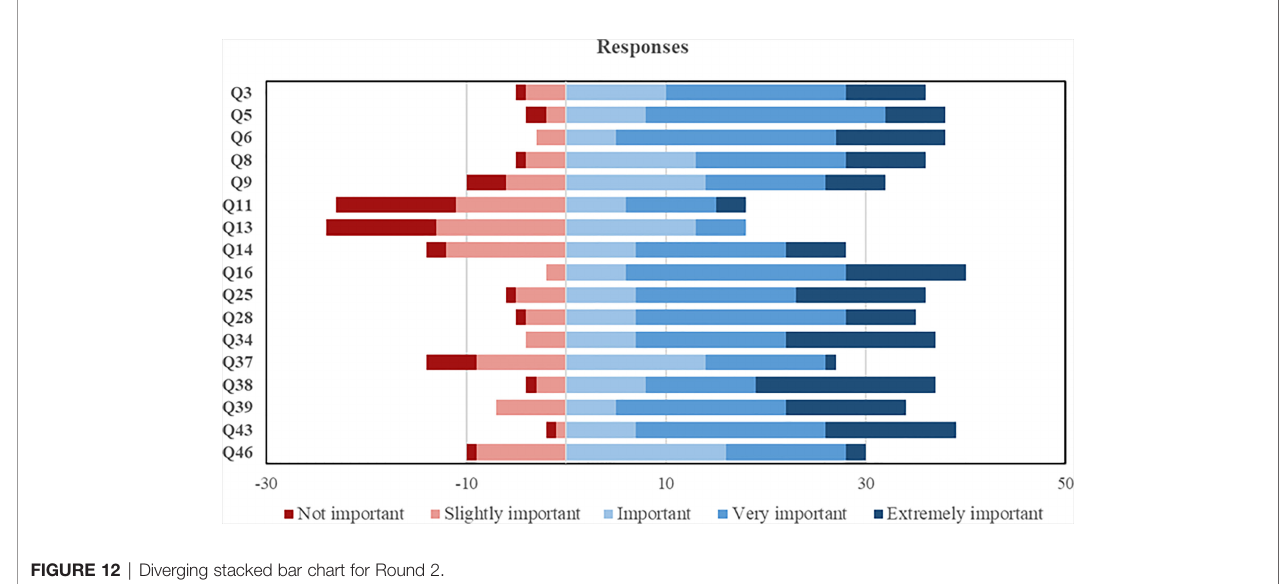
FIGURE 12 | Diverging stacked bar chart for Round 2.